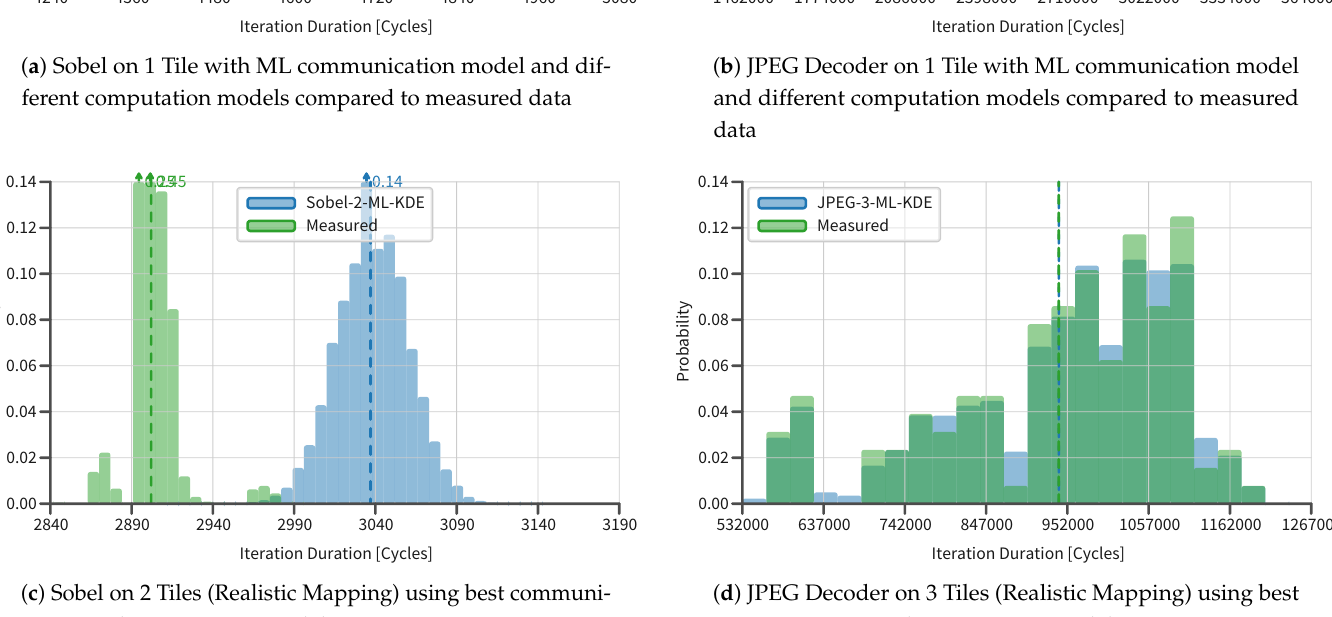
Figure 7. Comparison of the observed distribution of execution times with the simulated ones using different computation